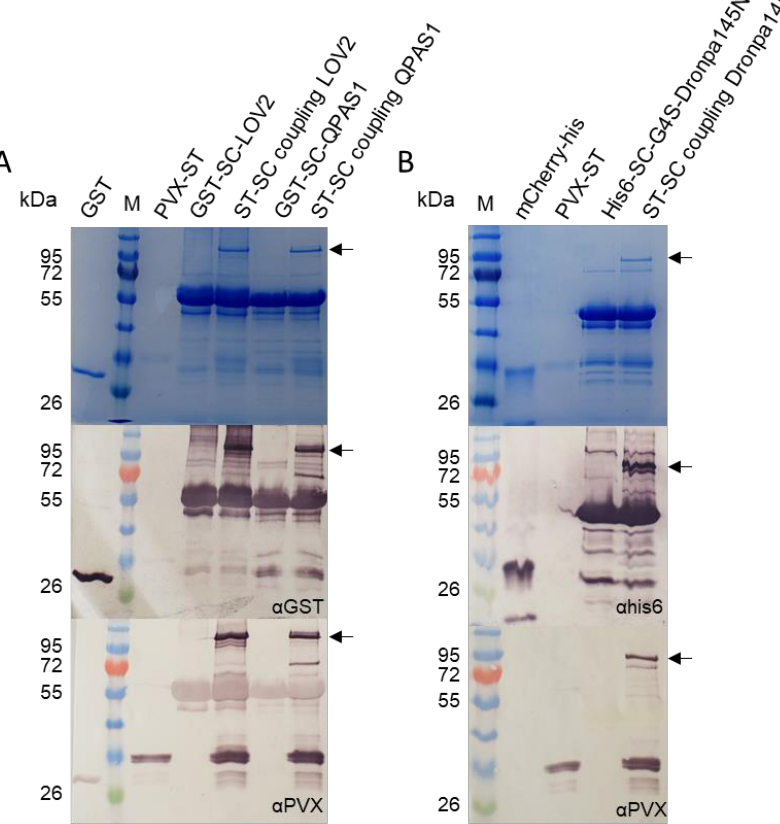
Figure 2. Coupling of purified optogenetic proteins to purified PVX-ST particles. ( A ) Conjugation of LOV2/QPAS1 to the surface of PVX particles using the ST-SC system confirmed by SDS-PAGE and Western blot. In addition to the bands for the individual GST-SC-LOV2 (57.1 kDa), GST-SC-QPAS1 (57.4 kDa) and ST-CP (27.4 kDa) proteins, a coupling band of ~85 kDa is present in Western blots probed with anti-GST and anti-PVX antibodies. ( B ) Conjugation of His 6 -SC-Dronpa145N to the surface of PVX particles using the ST-SC system confirmed by SDS-PAGE and Western blot. The anti-His 6 antibody detected the monomeric Dronpa145N protein (42.4 kDa) and a larger protein representing the coupling reaction (70 kDa) which was also detected by the anti-PVX antibody. M = P7719 Color Prestained Protein Standard. Purified GST (28 kDa), PVX-ST (27 kDa) and mCherry-His 6 (27 kDa) were loaded as controls. We mixed 3 µ g of PVX-ST with a two-fold molar excess of the SC-fusion protein before loading. The arrows indicate the assembled complexes: PVX-ST/GST-SC-LOV2 = 85.1 kDa, PVX-ST/GST-SC-QPAS1 = 85.4 kDa, PVX-ST/His 6 -SC- G4S-Dronpa145N = 69.2